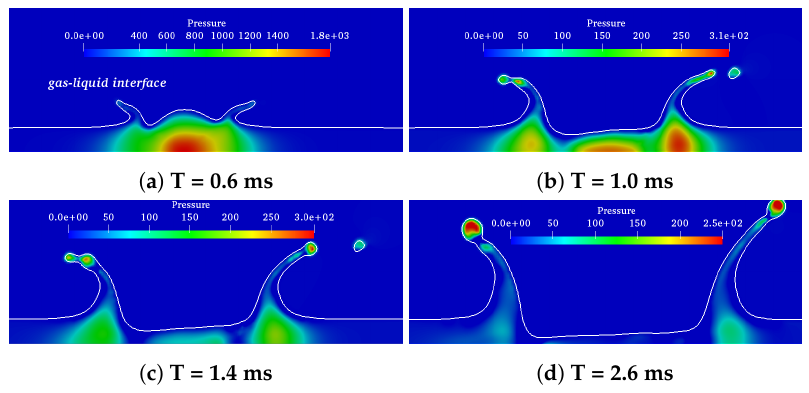
Figure 6. Pressure field distribution at θ = 30 ◦ . The relationship between the left crown height ( LCH ), right crown height ( RCH )